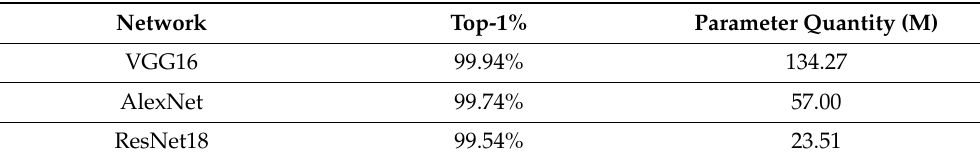
Table 1. Candidate teacher network; top-1%, parameter quantity, calculation amount, and inference time in NVIDIA Jeston